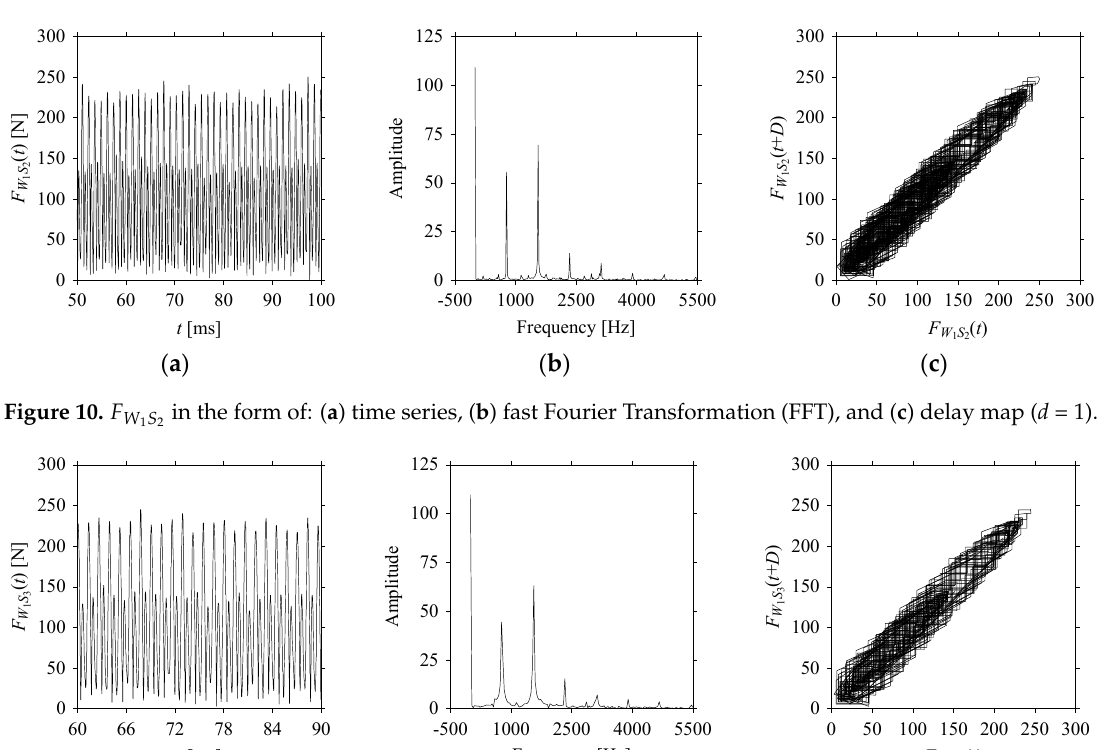
Sensors 2021 , 21 , x FOR PEER REVIEW